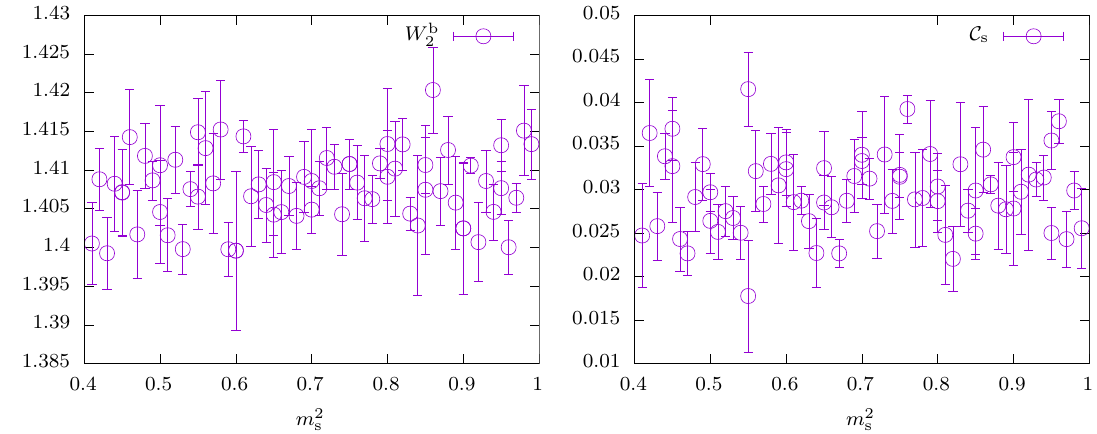
and on the right the term C s 2